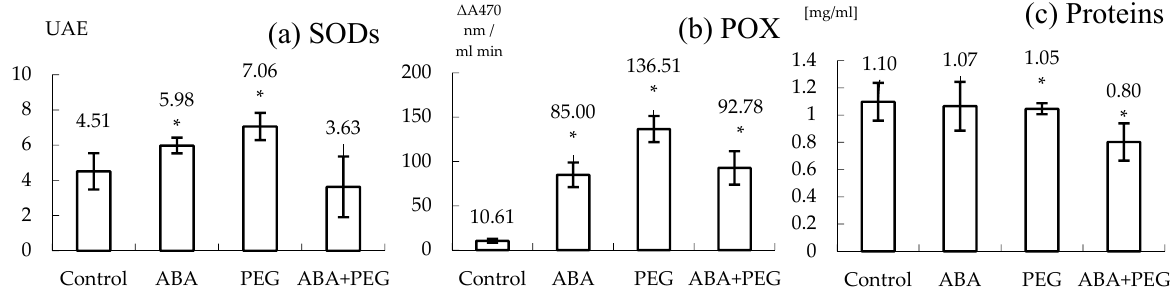
Figure 2. The effect of ABA and/or PEG on the SODs and POXs activities and on total protein content of the shooting hypocotyls in tobacco ( N. tabacum L., ‘Baladi’). A significant increase was recorded for SODs activity when ABA and PEG were added into the culture medium ( a ); A significant increase of POX activity was recorded for ABA and/or PEG ( b ). Proteins were significantly decreased only under both stressor presence: ABA and PEG ( c ). * Significant differences: <0.05.